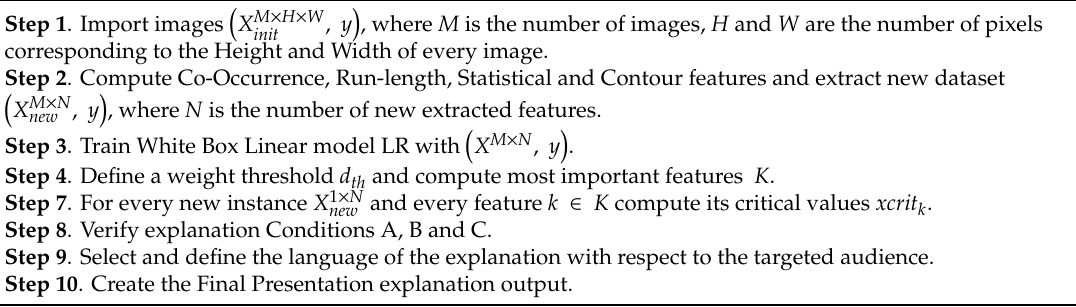
Table 4. Summary of proposed framework.